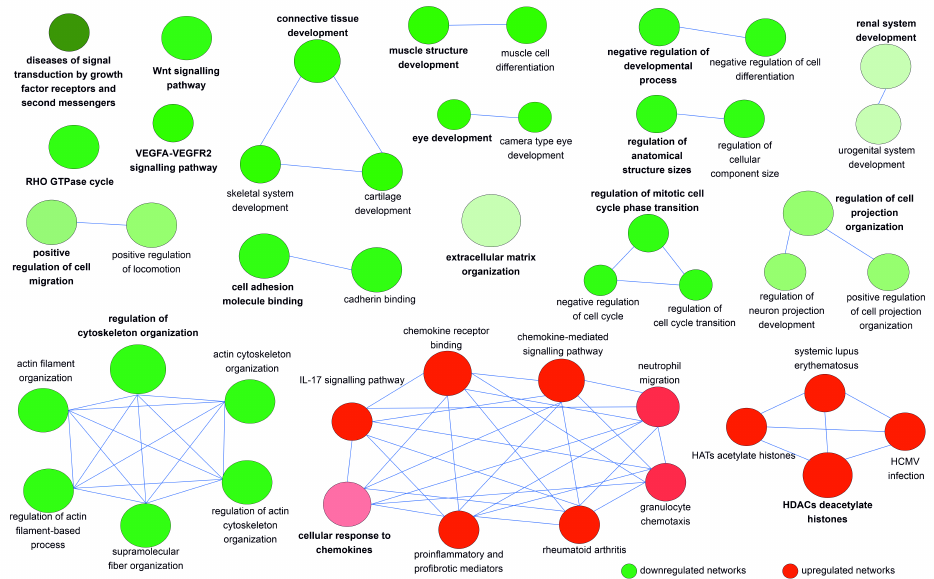
Figure 4. Network representation of enriched GO terms/pathways obtained from the differentially expressed genes in hEDS/HSD. Functionally grouped clusters based on “Biological Process” and “Molecular Function” GO categories and WikiPathways, KEGG and Reactome pathways with terms as nodes linked based on their κ score level = 0.7 through Cytoscape. The GO terms “fusion” and “all experimental evidence” were selected to create the network. Two-sided hypergeometric test and Benjamini–Hochberg statistical correction were applied and only enriched pathways with a p -value ≤ 0.01 were selected. Other considered parameters were minimum and maximum tree GO interval values of 3–8, with a minimum number of three genes and 7% of genes selected for GO terms. Different node colors represent different GO categories/enriched pathways: green identify downregulated clusters, red upregulated ones. The increase in green and red color gradient represents higher amounts of the contribution of up- and downregulated genes, respectively. The size of the nodes is indicative of their statistical significance of the